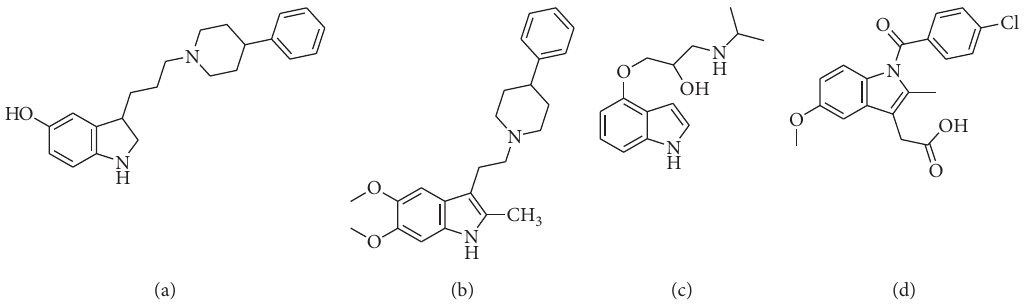
Figure 1: Representative examples of drugs with indole. (a) Roxindole schizophrenia. (b) Oxypertine antipsychotic drug. (c) Pindolol antihypertensive drug. (d) Indometacin anti-inflammatory drug.